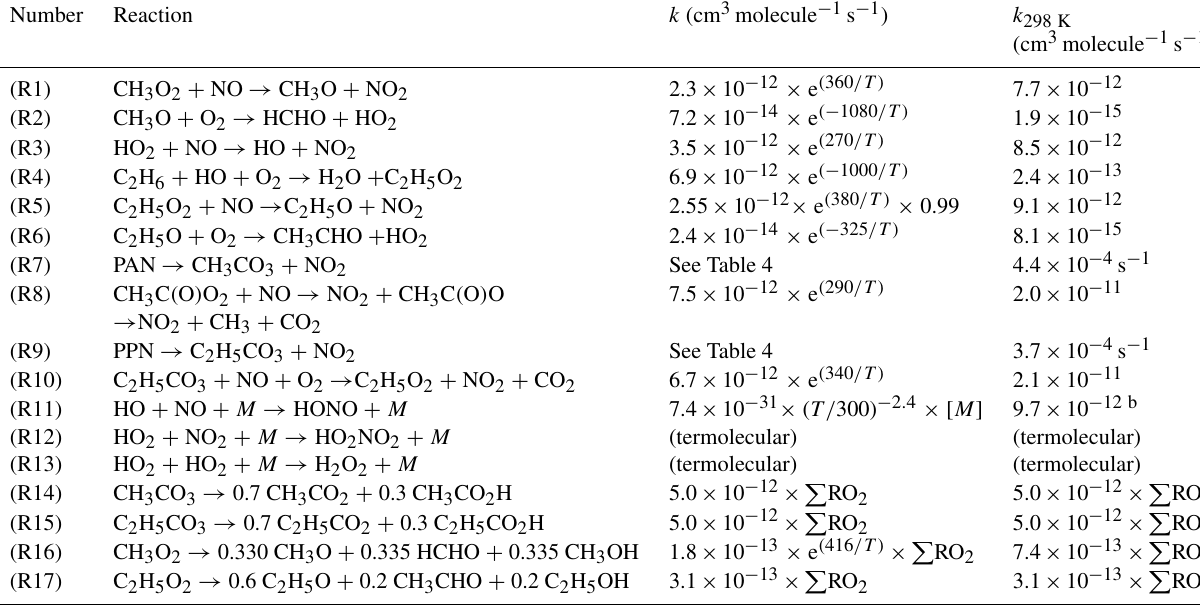
Table 3. List of chemical reactions a .